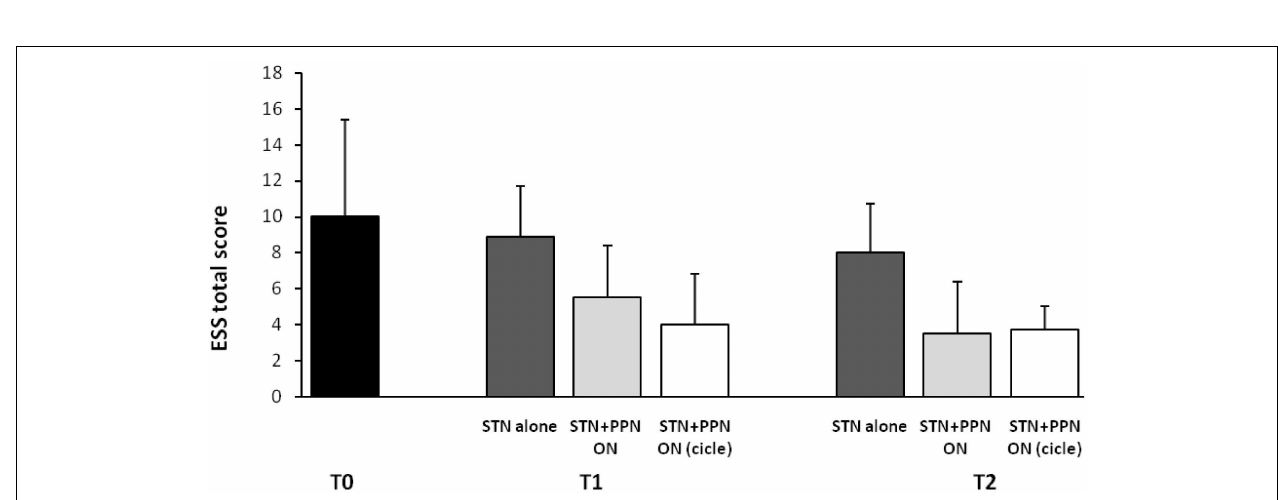
12months (T2) following surgery completion. A modest but significant amelioration of diurnal drowsiness is detected when PPTg-ON is introduced (for details, see Peppe et al.,